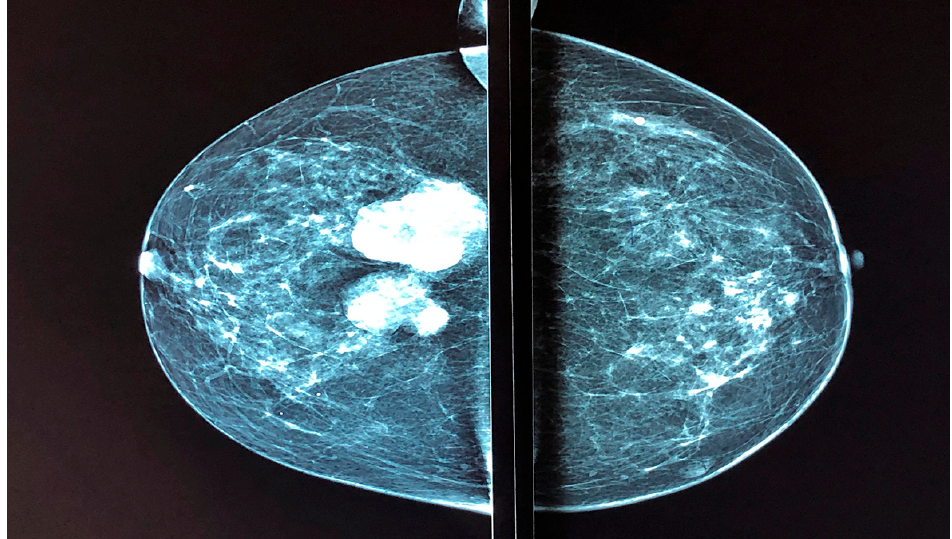
Figure 1. Screening mammogram.